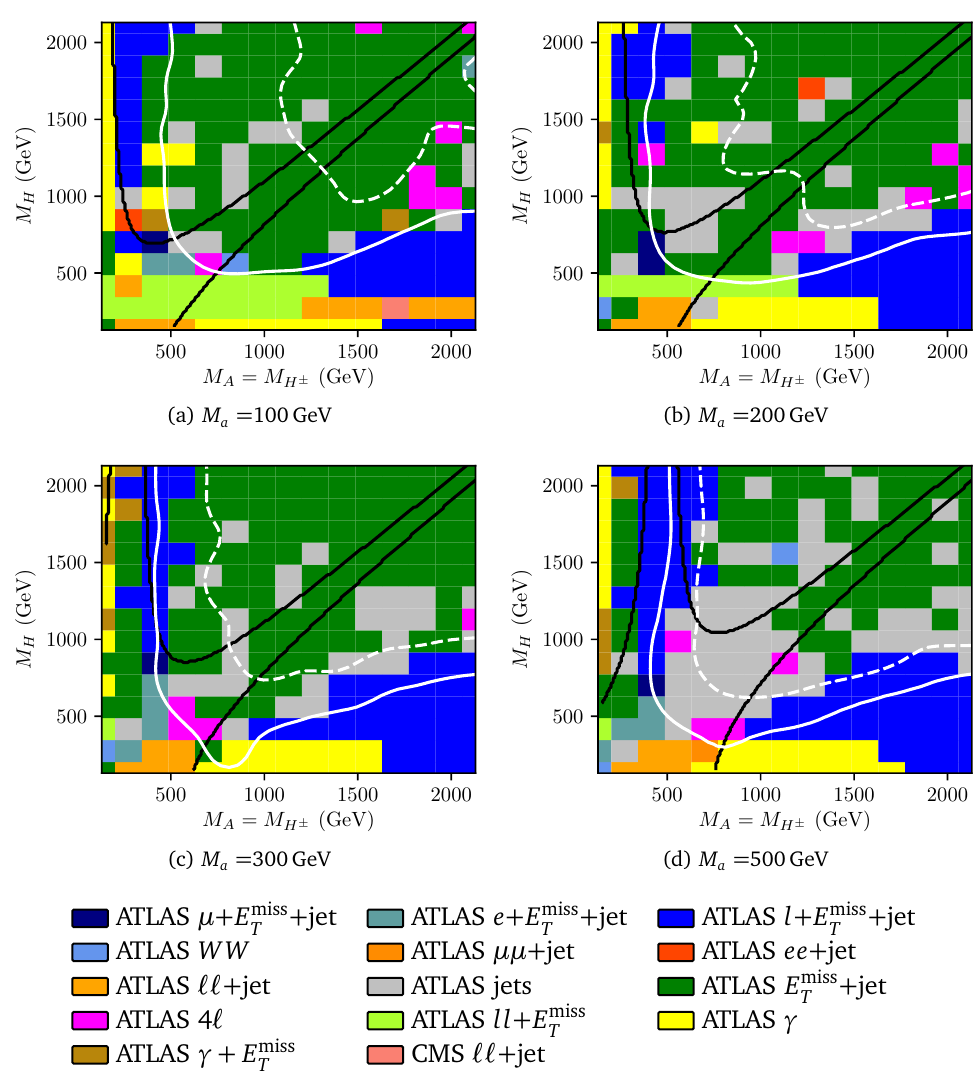
= M vs M for different M . The 95% (68%) H A H ± a